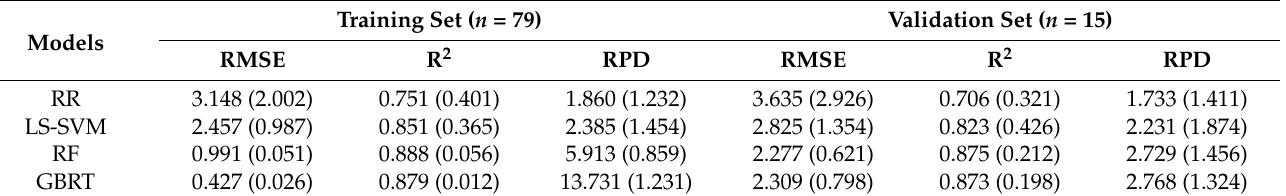
Table 2. Evaluation of XWT-based framework in terms of RMSE, R 2 , and RPD through 20-fold cross- validation on our randomly split training set ( n = 79) and validation set ( n = 16). The average and standard deviation (in brackets) of the accuracy validation metrics were computed for the XWT-based framework, coupled with RR, LS-SVM, RF, and GBRT.